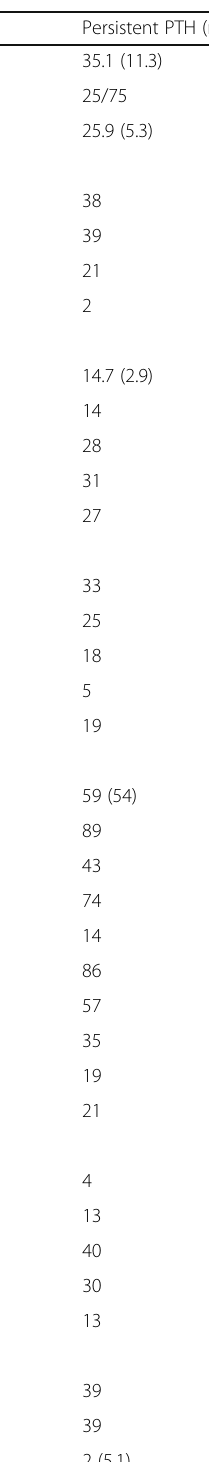
Table 1 Baseline Participant